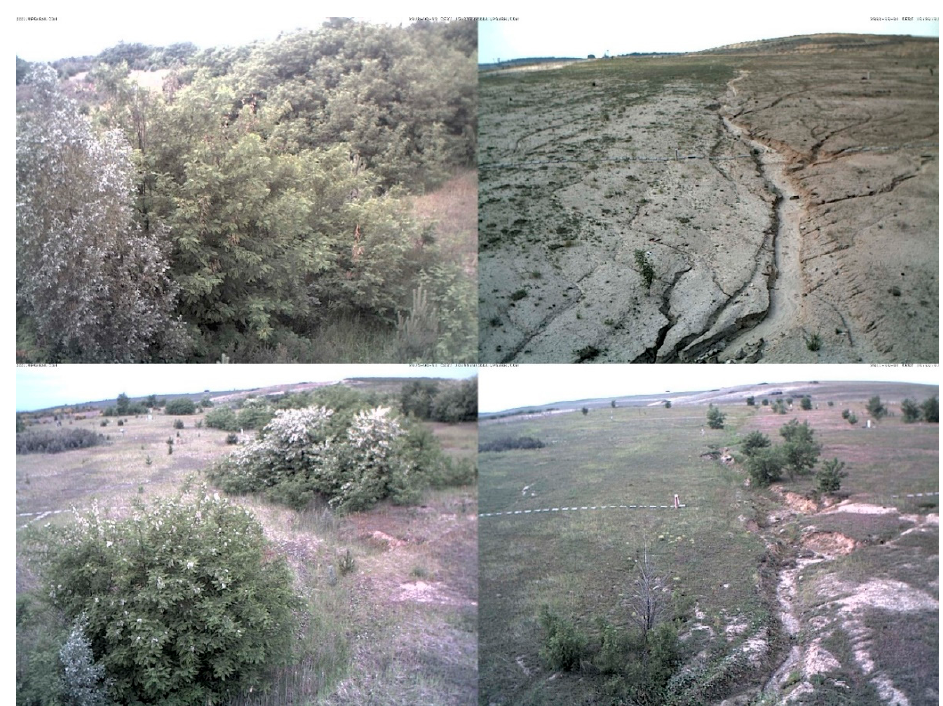
Figure 2. View north over the Hühnerwasser catchment area, from a webcam mounted at 6 m height. The date of each photo is June, clockwise from top right, ( top right ) in 2008, ( bottom right ) 2011, (bottom left ) 2015, and ( top left ) 2018.